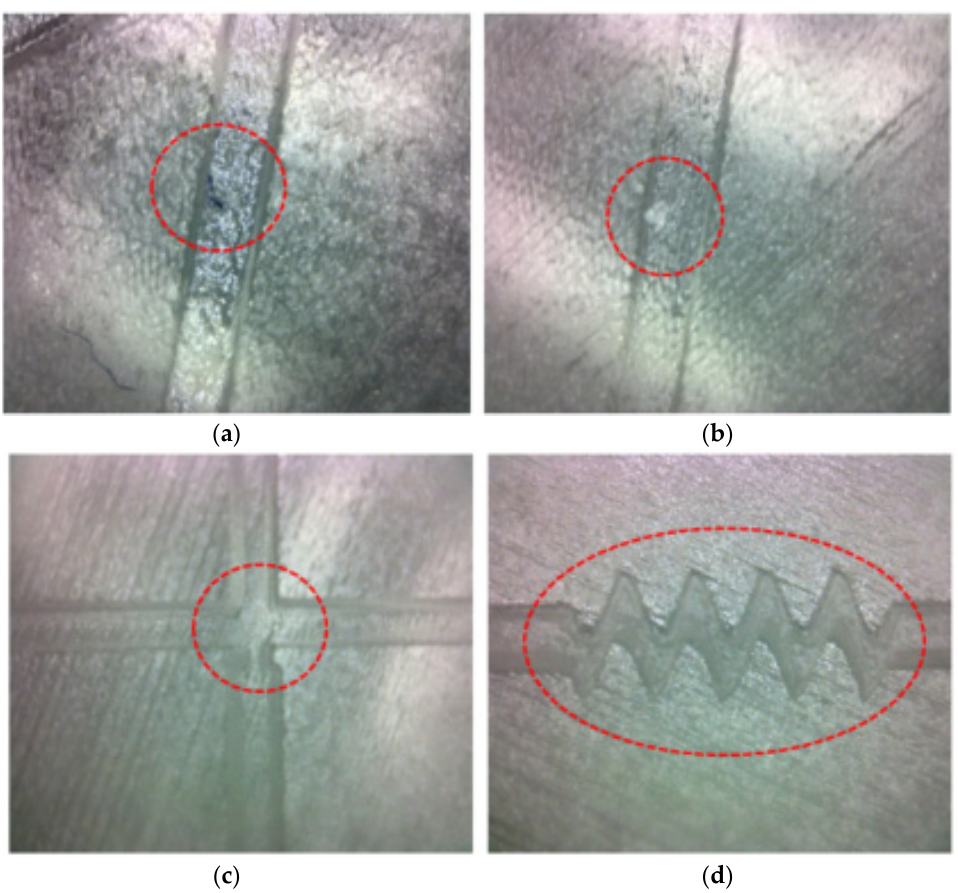
Figure 4. ( a , b ) There are obvious surface impurities problems. ( c , d ) It can be seen that the forming at the shrinkage part meets the design requirements.